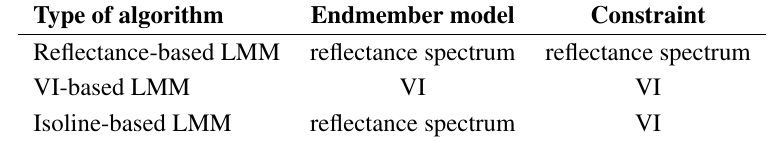
Table 1. Assumed endmember variables and constraints in the three LMM-based